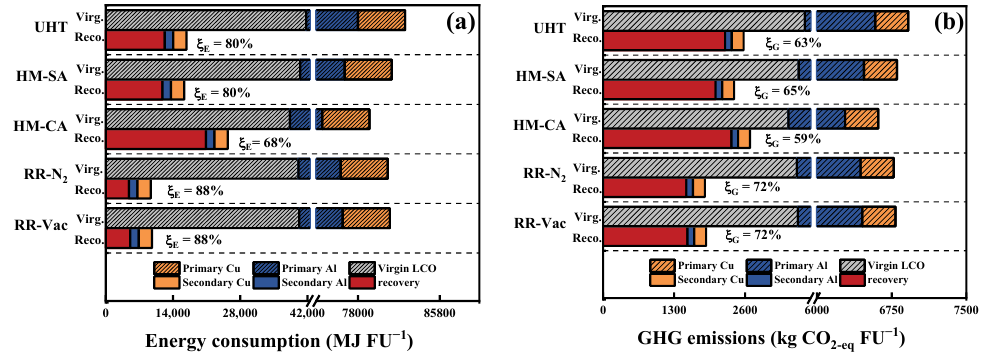
Figure 9. Contribution analysis of energy consumption ( a ) and GHG emissions ( b ) for the five different recycling methods. Each pair of bars is related to a method, where the bottom bar represents the energy consumption ( a ) or GHG emissions ( b ) required for each recycling method and Cu and Al recovering processes for 1 FU, the top bar is the energy consumption ( a ) or GHG emissions ( b ) for an equivalent weight virgin LCO and primary Cu and Al production in industry, and the difference represents the energy saving. The numbers indicate the reduction rate of energy consumption ( a ) or GHG emis- sions ( b ) from 1 FU for each method.